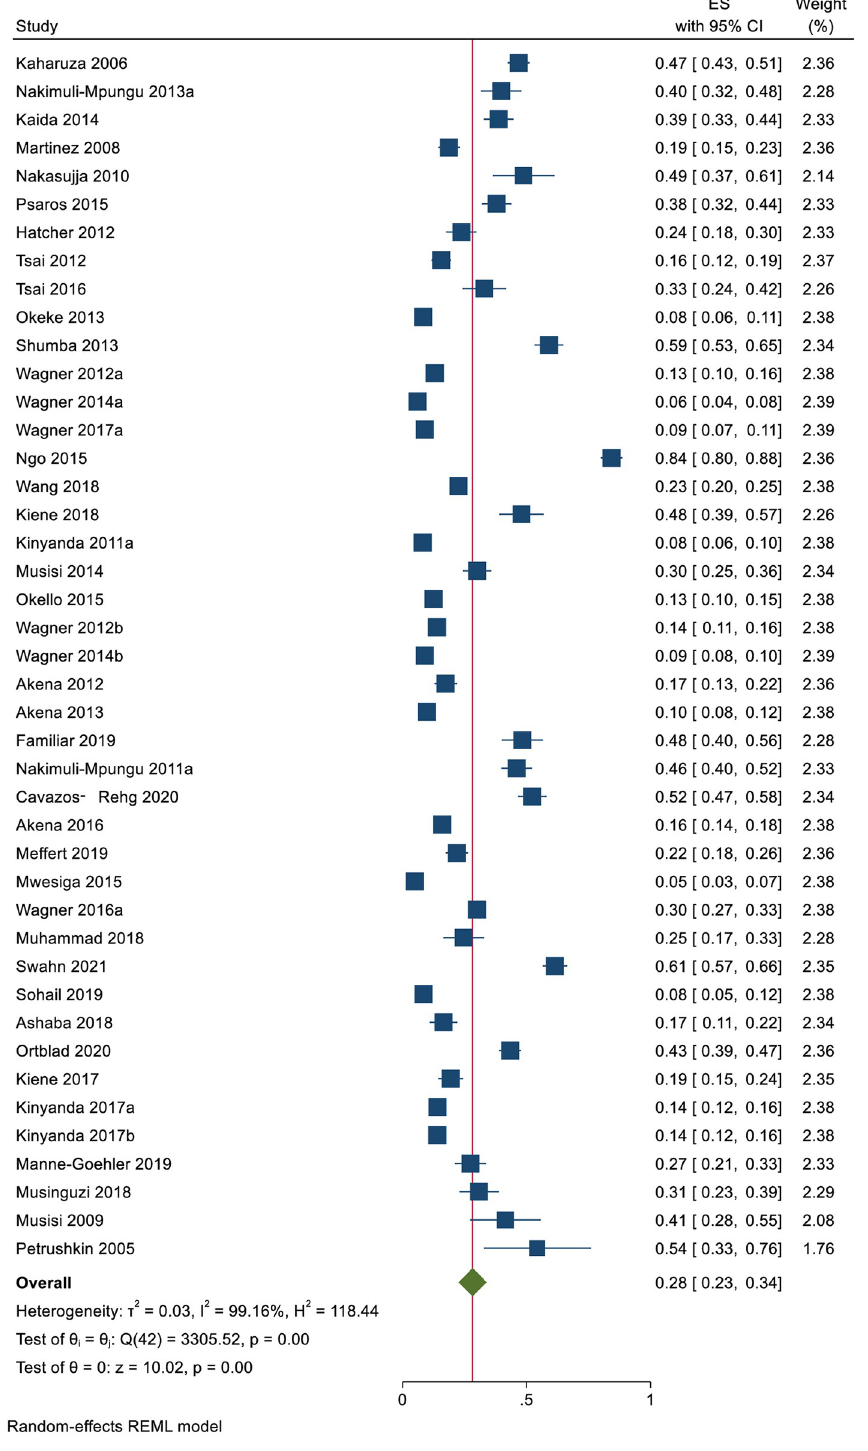
Fig 10. Forest plot on the prevalence of depression among individuals living with HIV in Uganda.